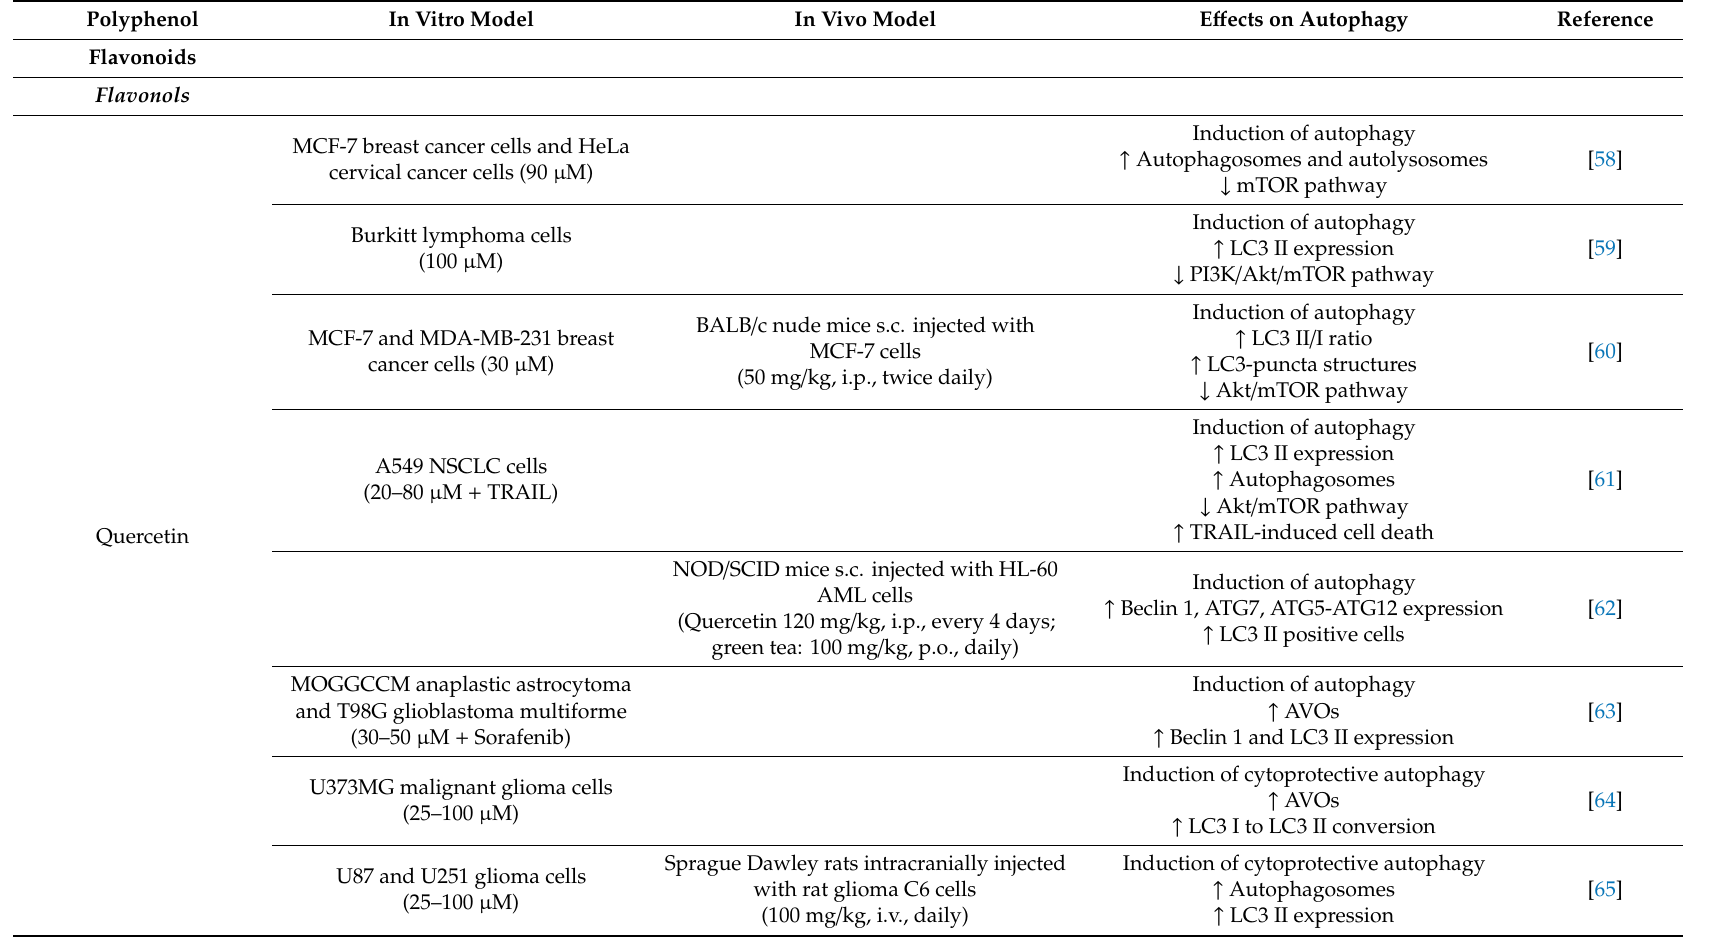
Table 1. In vitro and in vivo e ff ects of polyphenols on autophagy in